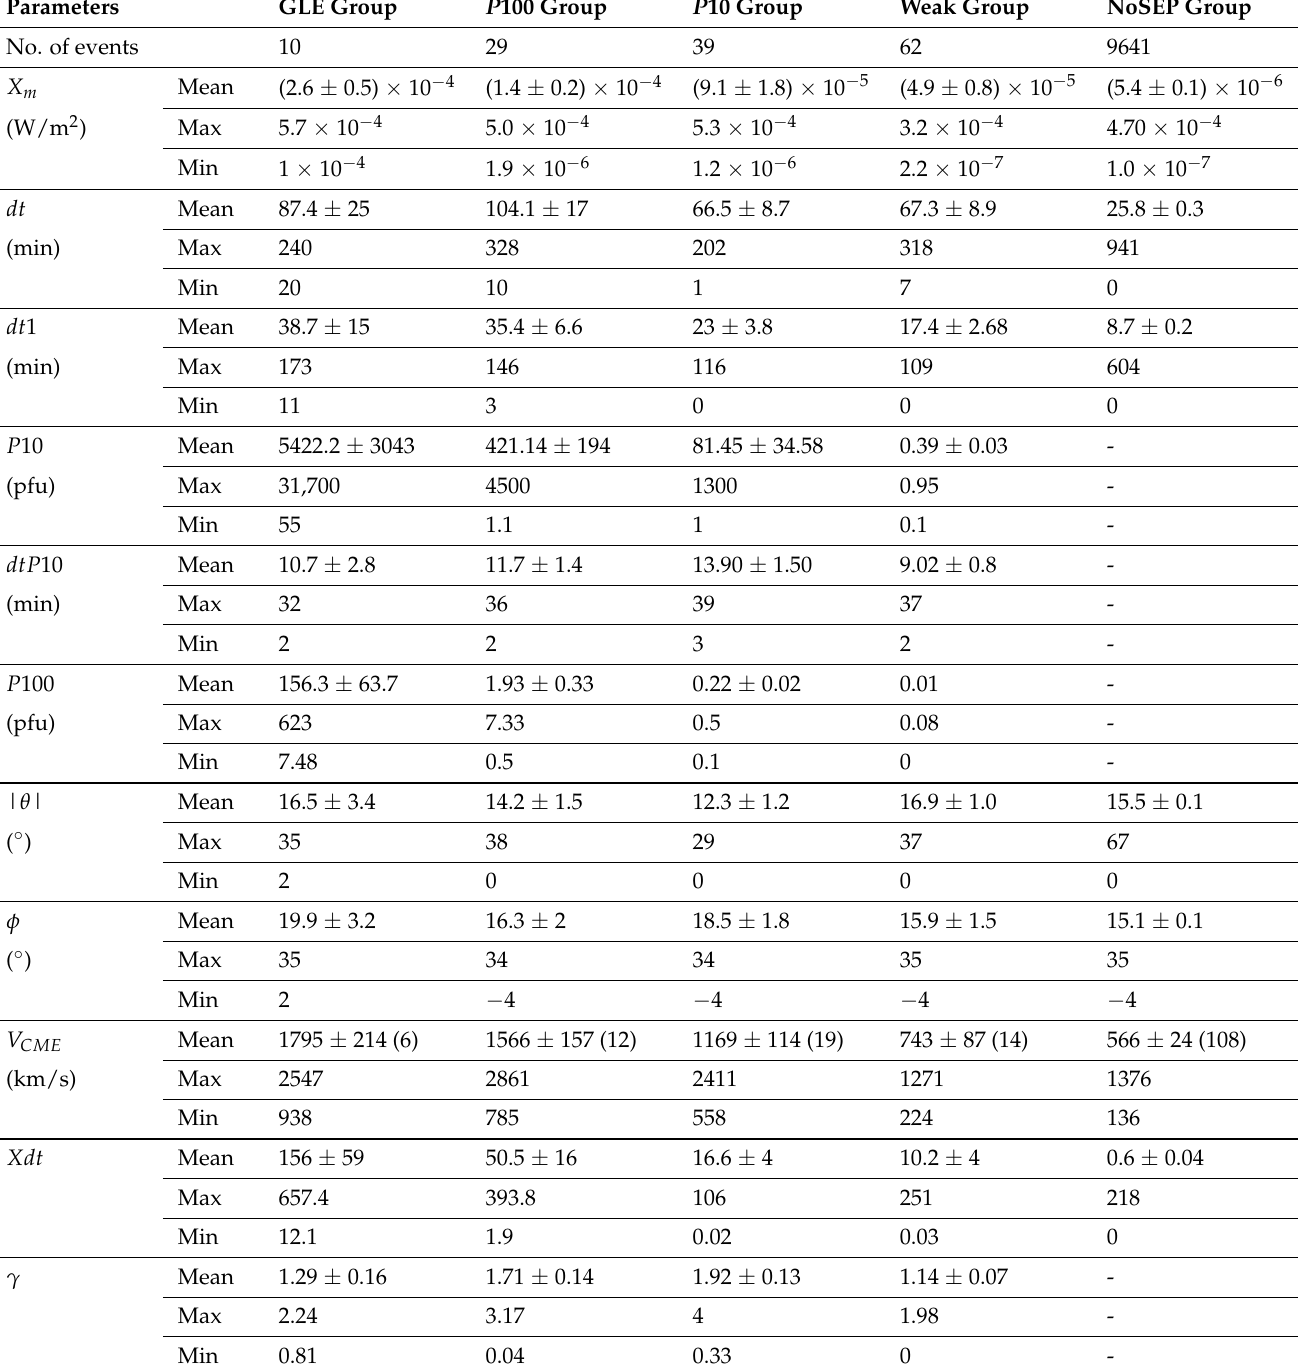
Table 1. Mean, maximum, and minimum values of the main parameters of solar flare events from different groups under